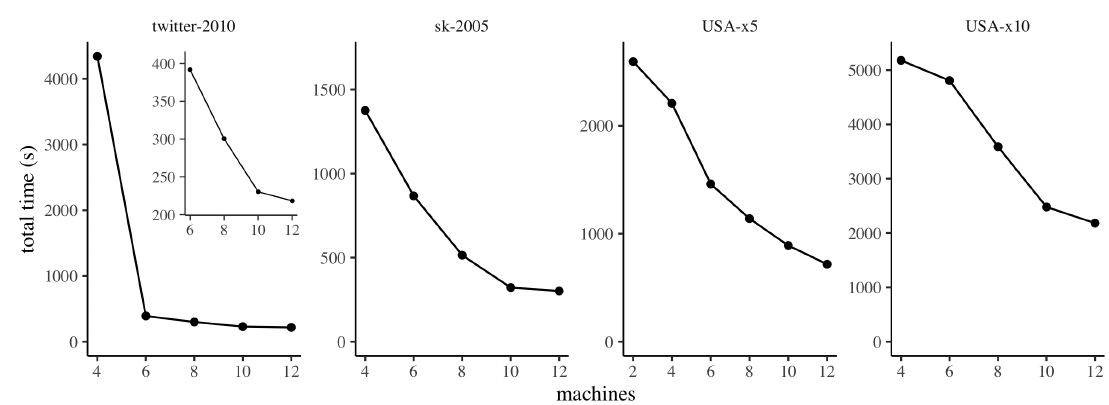
Figure 7. Strong scaling of C LUSTER D IAMETER . For twitter-2010 , the smaller plot details the strong scaling between 6 and 12 machines, for